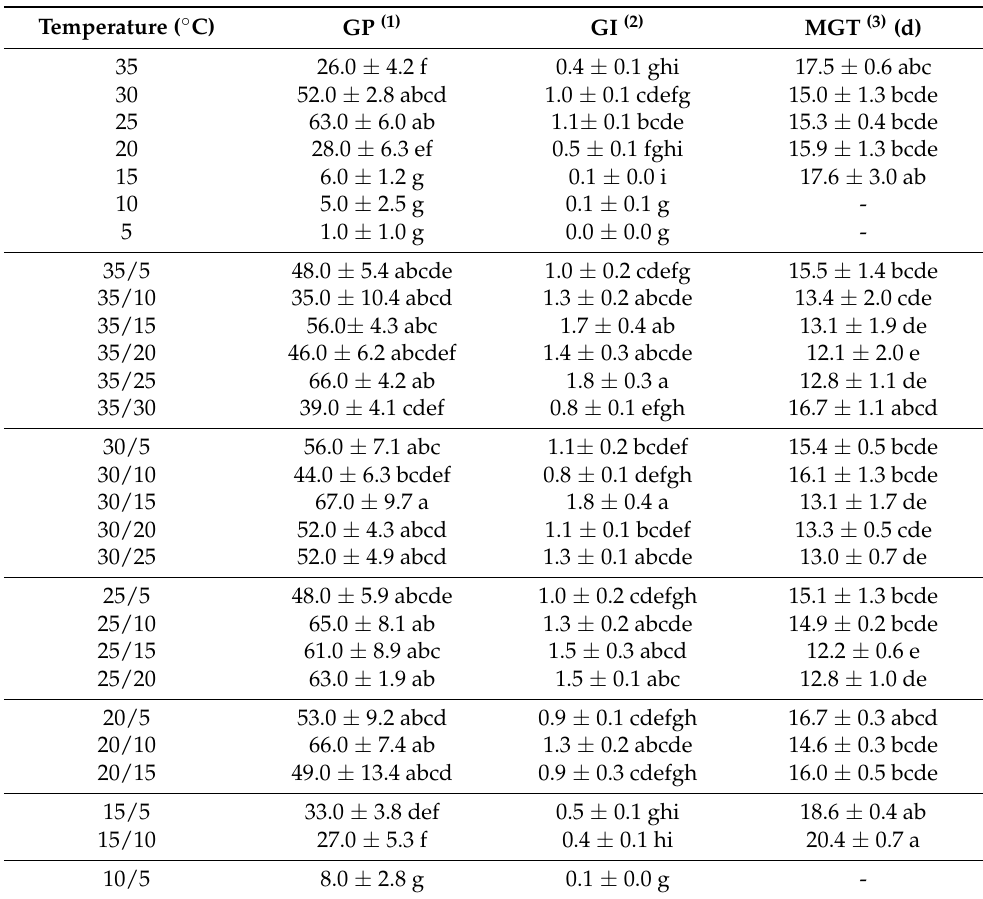
Table 3. Germination (mean ± standard error) of non-stratified F. rhynchophylla seeds at different